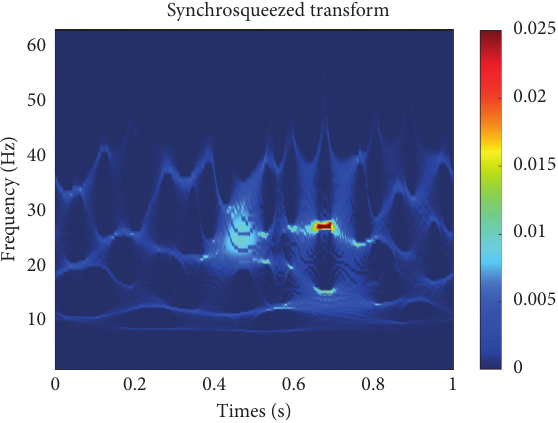
Figure 5: TF spectrum of the linear model.